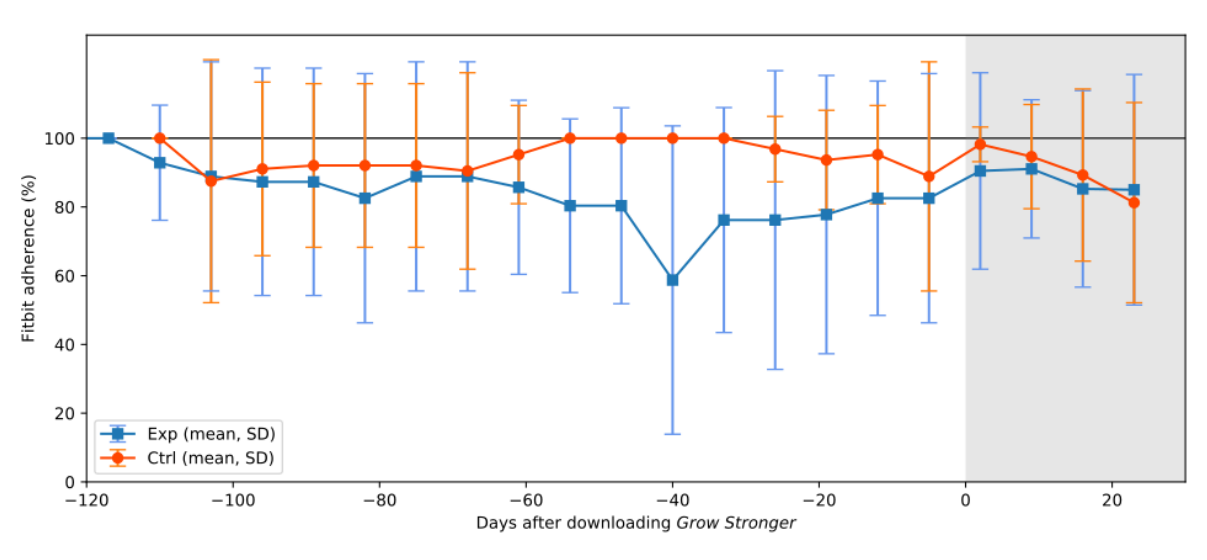
Figure 5. Average weekly adherence to wearing Fitbits in each group before and after the Grow Stronger app was downloaded by the experiment group. The period where each participant had downloaded the game is indicated by the shaded background. The control group, which did not download the game, were aligned with the majority of the experiment group for ease of comparison. As weeks are assumed to start on Mondays, but most participants downloaded the game on a Friday (day 0), the value for the final week before the game was downloaded (the last week in the unshaded area) included values from days 1 and 2 after the game was downloaded. All participants are included in the data presented in this figure. Ctrl: control; Exp: experiment.